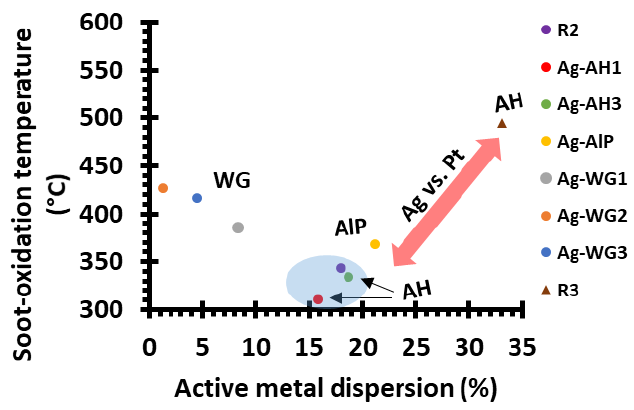
Figure 5. Relationship between the soot-oxidation temperature and the degree of active-metal dispersion. The blue area highlights the most promising catalysts. For more details about the catalysts, see Table 1.